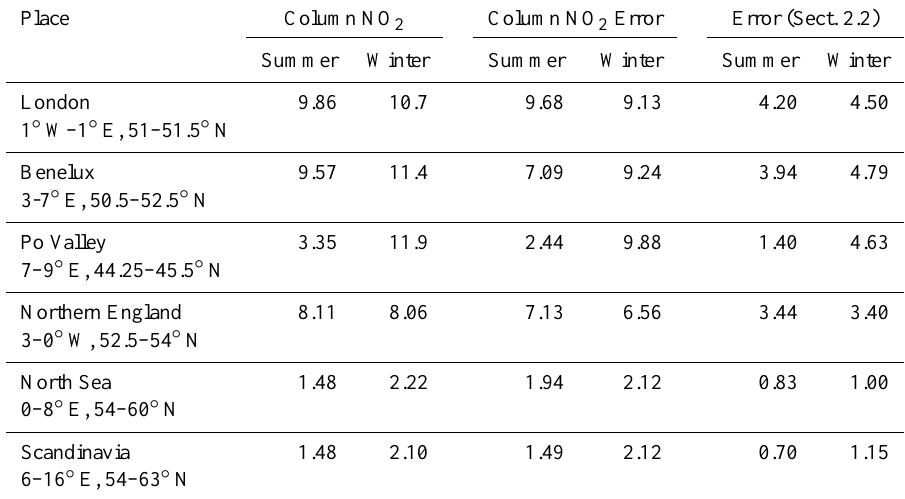
Table 1. The average column NO 2 , column NO 2 error and column NO 2 error as calculated in Sect. 2.2 for multiple locations across Europe in summer and winter ( × 10 15 moleculescm − 2 ). Place Column NO 2 Column NO 2